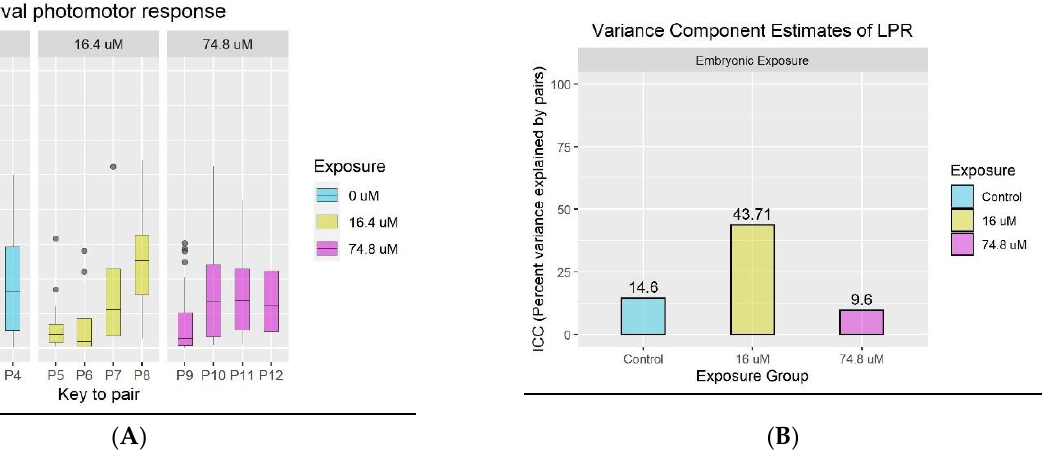
Figure 2. ( A ) Box plot showing total distance moved during dark phase of LPR assay broken down by pairs from each exposure group. ( B ) Variance Component Estimates. Bar plot showing percent of total variance explained by Family ID in each exposure